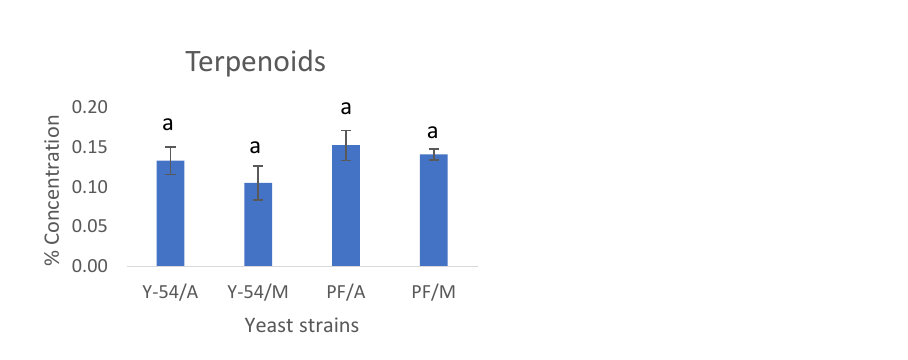
Figure 7. Percent concentrations of the most important groups of volatile compounds: esters (ethyl, acetic), ketones, aldehydes, fatty acids, higher alcohols and terpenoids. Y-54/A: Assyrtiko wine made with S. cerevisiae LMBF Y-54; Y-54/M: Mavrotragano wine made with S. cerevisiae LMBF Y-54; PF/A: Assyrtiko wine made with S. cerevisiae Passion Fruit; PF/M: Mavrotragano wine made with S. cerevisiae Passion Fruit. Columns with different letters are significantly different ( p < 0.05).